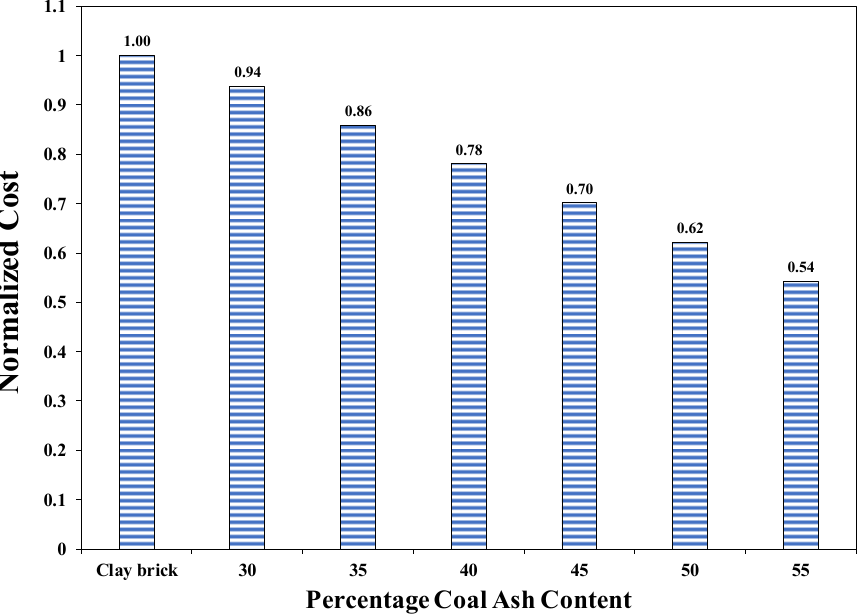
Figure 19. Cost Comparison of Coal Ash and Burnt Clay brick.